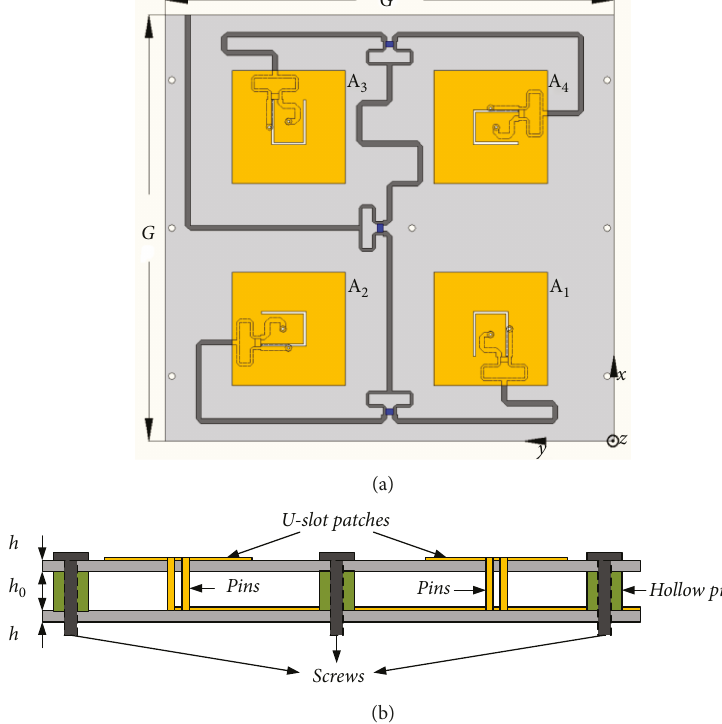
Figure 3: Structures of the corresponding 2 × 2 array. (a) Top view of the array. (b) Side view of the array. Dimensions of the array (unit: mm): G = 190